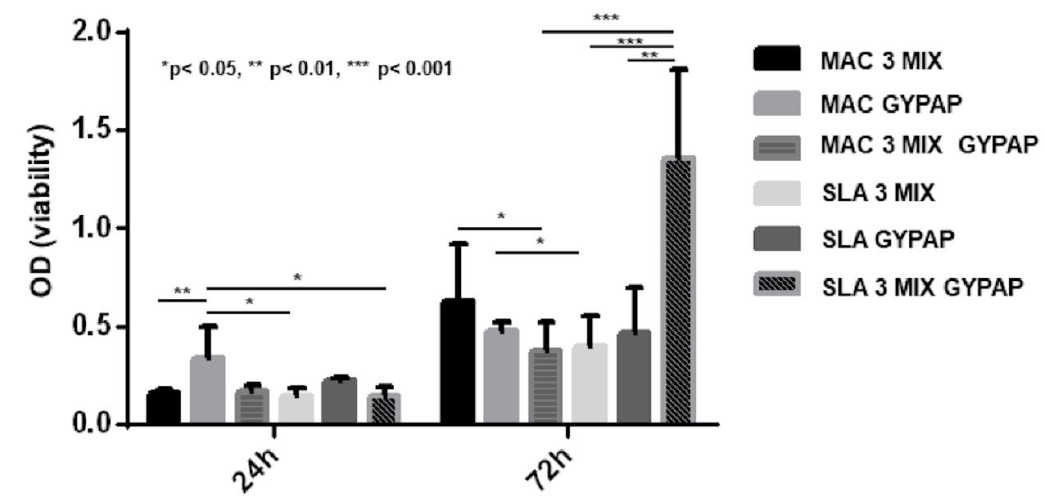
Figure 5. ASC viability. The graph shows the ASC viability on the disks decontaminated, after 24 and 72 h.